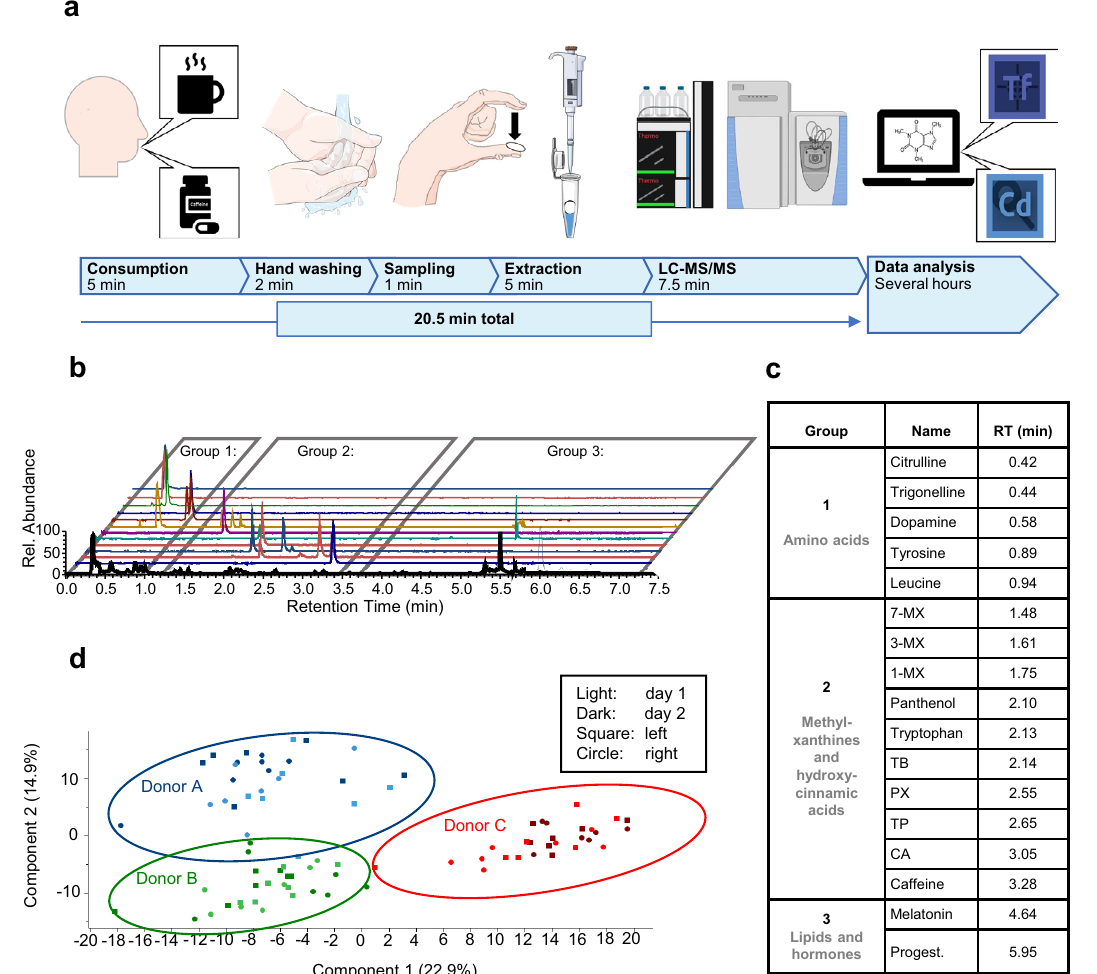
Fig. 1 Sweat from the fi ngertips enables individualised metabolic biomonitoring. A straight-forward work fl ow for sweat sampling and processing was established and successfully applied to proof-of-principle studies to investigate caffeine metabolism in an individualised fashion. a Graphical summary of the work fl ow including consumption of a cup of coffee or a caffeine capsule, sampling sweat from fi ngertips, the extraction of analytes and subsequent LC-MS/MS analysis as well as data analysis with respective durations in minutes. Panel a was modi fi ed from Servier Medical Art, licensed under a Creative Common Attribution 3.0 Generic License (http://smart.servier.com/) and BioRender (https://biorender.com/). Tf Trace fi nder Software, Cd Compound Discoverer Software (both Thermo Fisher Scienti fi c). b Extracted ion chromatograms of exemplary sweat components are shown. Based on their retention time, analytes were assigned to three groups as listed in c . c Identities of sweat constituents according to order of elution. CA chlorogenic acid, MX methylxanhine, PX paraxanthine, TB theobromine, TP theophylline, Progest. progesterone. d Principal component analysis (PCA) of fi nger sweat samples derived from the left (square) and right (circle) hand of three participants is depicted before and after coffee consumption at two different days (light and dark colour). PCA was calculated with a set of 250 metabolites (Supplementary Data 1) and successfully clustered the fi nger sweat samples according to the